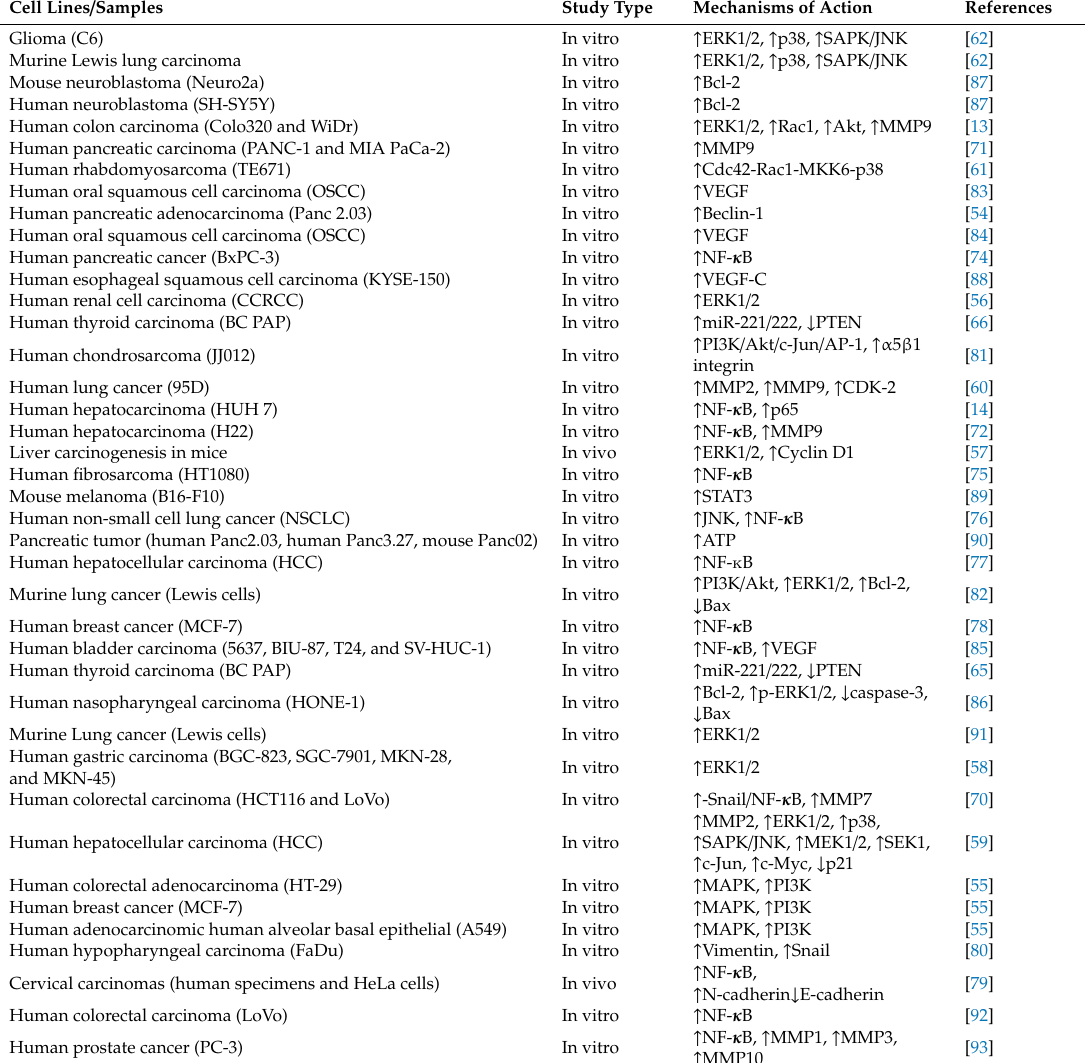
Table 2. Role of the high-mobility group box1 (HMGB1-receptor for advanced glycation end product (RAGE) axis in cancer